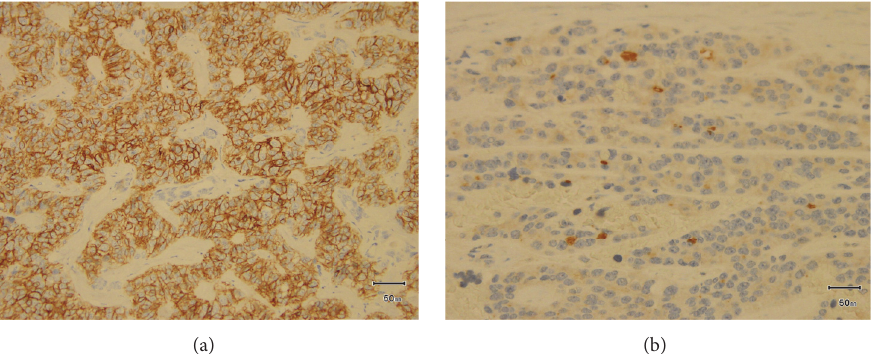
Figure 5: Immunohistochemical staining. The staining was positive for CD56 (a) and slightly positive for chromogranin A